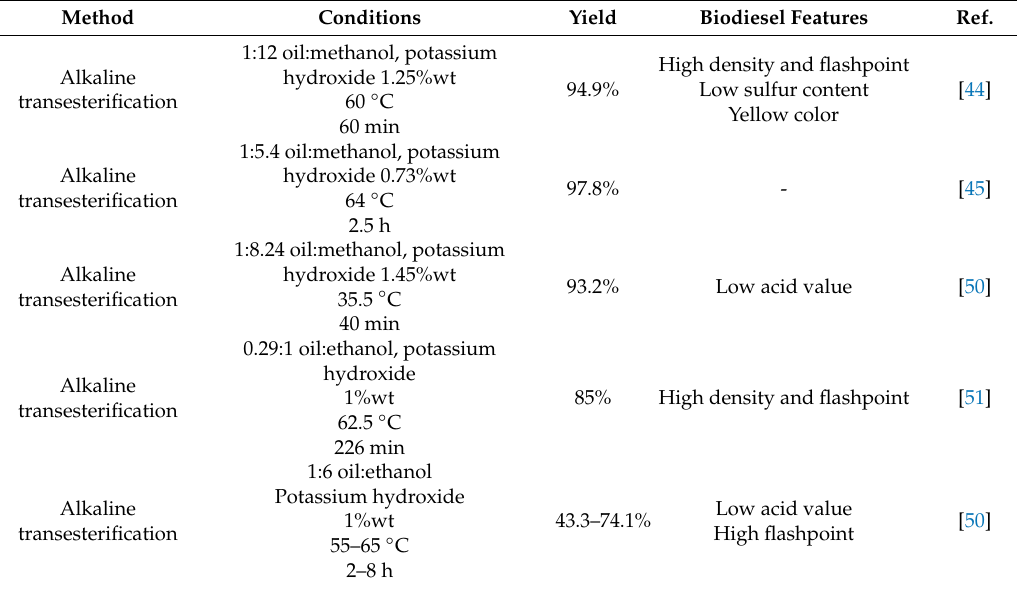
Table 3. Alkaline transesterification used in biodiesel production from castor